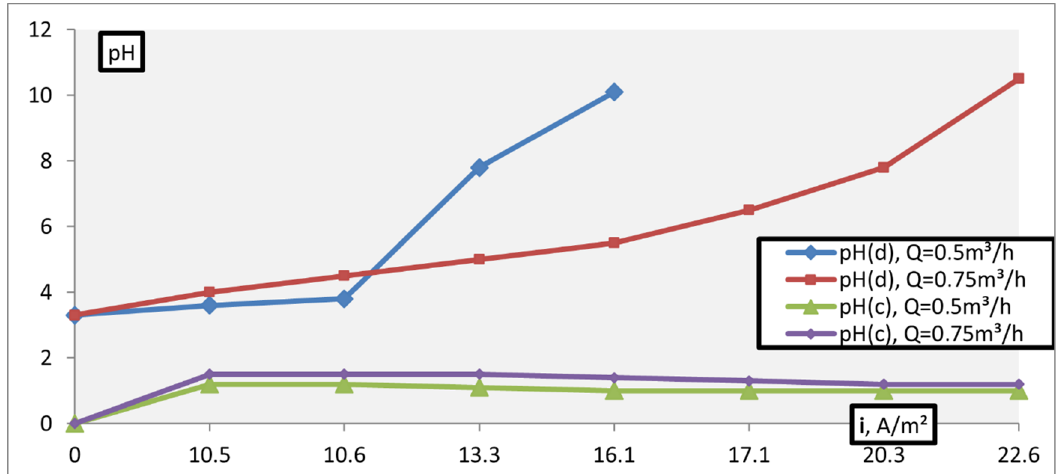
Figure 10. pH adjustment of acidic solutions (pH = 3.3).